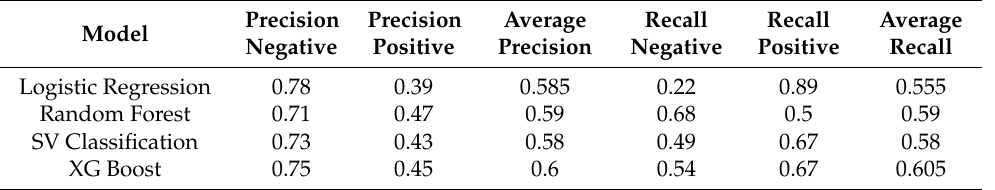
Table 3. Precision and recall for each machine learning